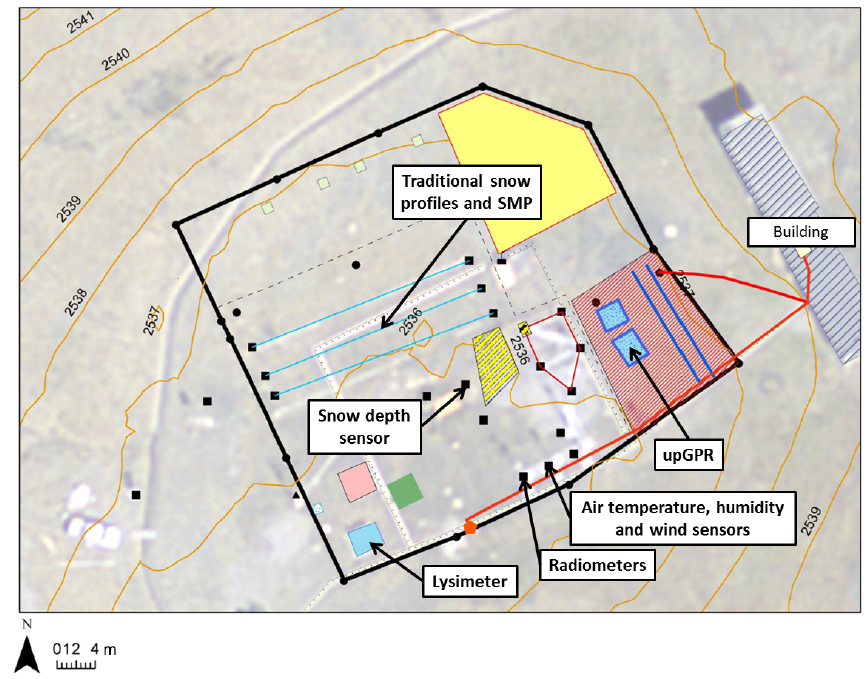
Figure 1. Overview of the WFJ research field with contour lines in orange and labels indicating the location of the measurements used in this study.